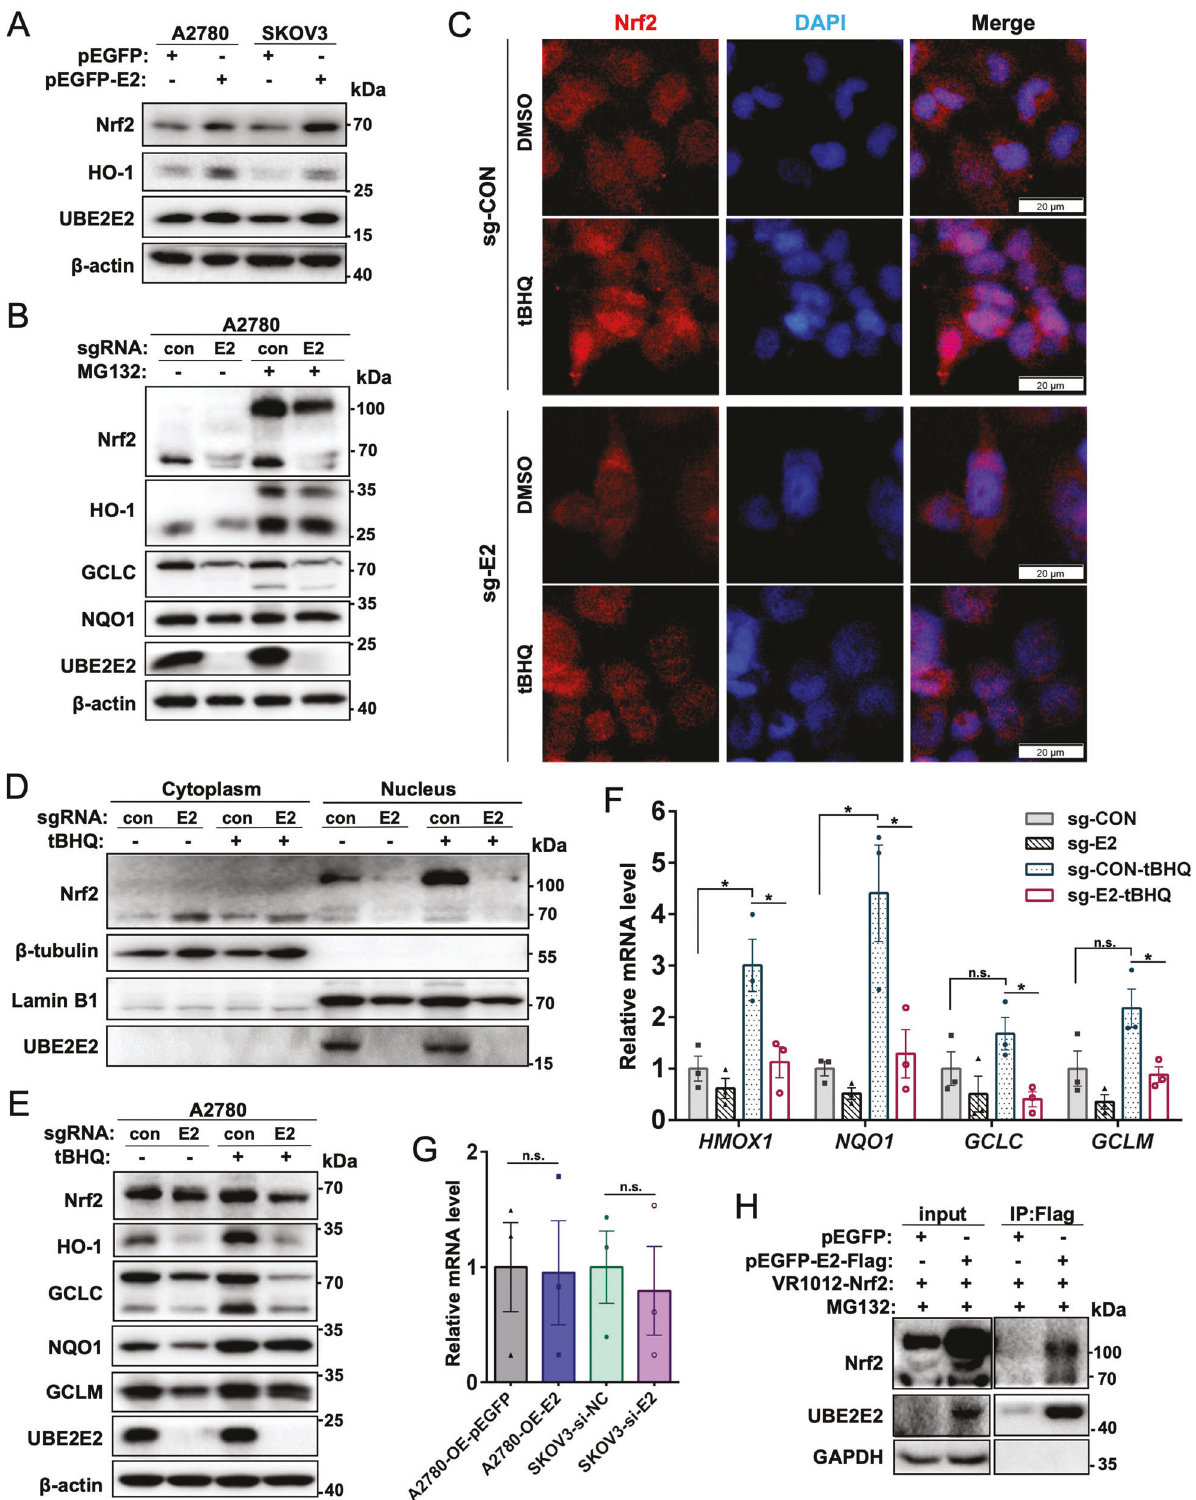
Fig. 5 UBE2E2 regulates Nrf2 expression and nuclear translocation. A , B The expression of Nrf2 pathway proteins was explored by western blotting with β -actin as the loading control. MG132, which is used to block the proteasome system, was added to the cultures ( fi nal concentration of 10 μ M) 12 h prior to cell harvesting. C The subcellular distribution of Nrf2 was assessed by immuno fl uorescence staining. An overlay of blue (nuclei) and red (Nrf2) channels is shown (scale bar = 20 μ m). D The cytoplasm and nuclear fractions were analyzed by immunoblotting with β -tubulin, and Lamin B1 as markers for cytosol and nuclear fractions, respectively. E The expression of Nrf2 pathway proteins was detected by immunoblotting. F The mRNA levels were measured by qRT – PCR (* p < 0.05; n.s. no signi fi cant differences detected). G The mRNA expression level of Nrf2 in OvCa cells was measured by qRT – PCR. H Immunoprecipitation (IP) of Flag-tagged UBE2E2 in SKOV3 cells. Cell Death and Disease (2023)